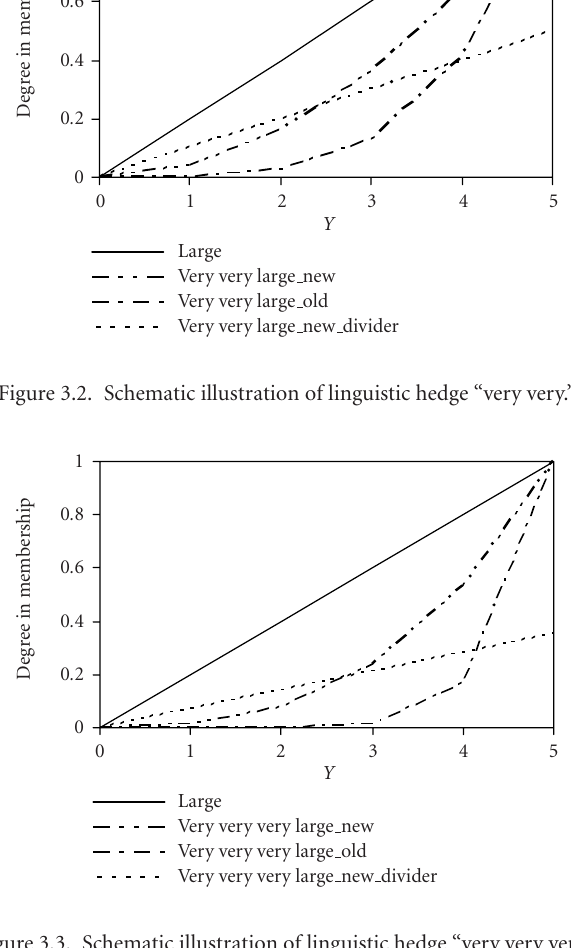
Figure 3.3. Schematic illustration of linguistic hedge “very very